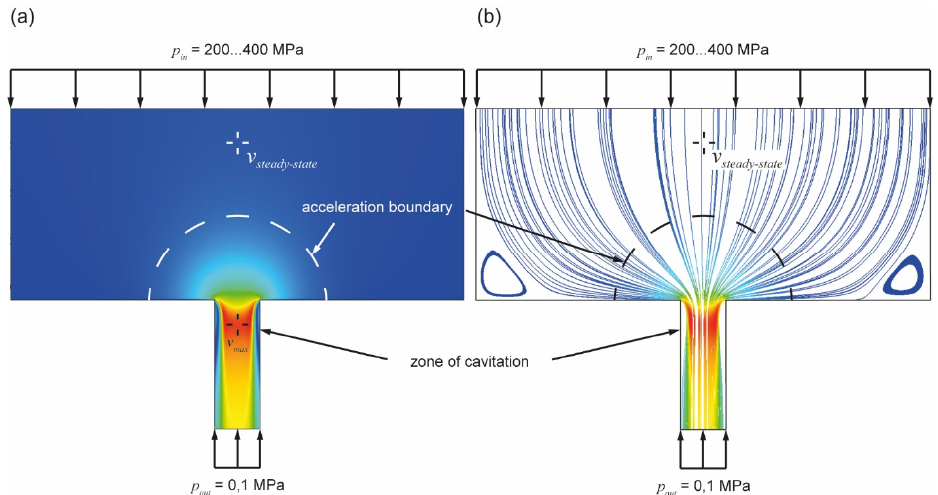
Figure 12. Normalized representation of the results of the numerical calculation of the flow field through an orifice with a bore diameter of 300 µm: ( a ) velocity distribution and ( b ) streamlines of the flow field; in each case, the boundary from where the flow is accelerated from its quasi-stationary value to the jet exit velocity and the cavitation zones in the orifice bore are labeled.